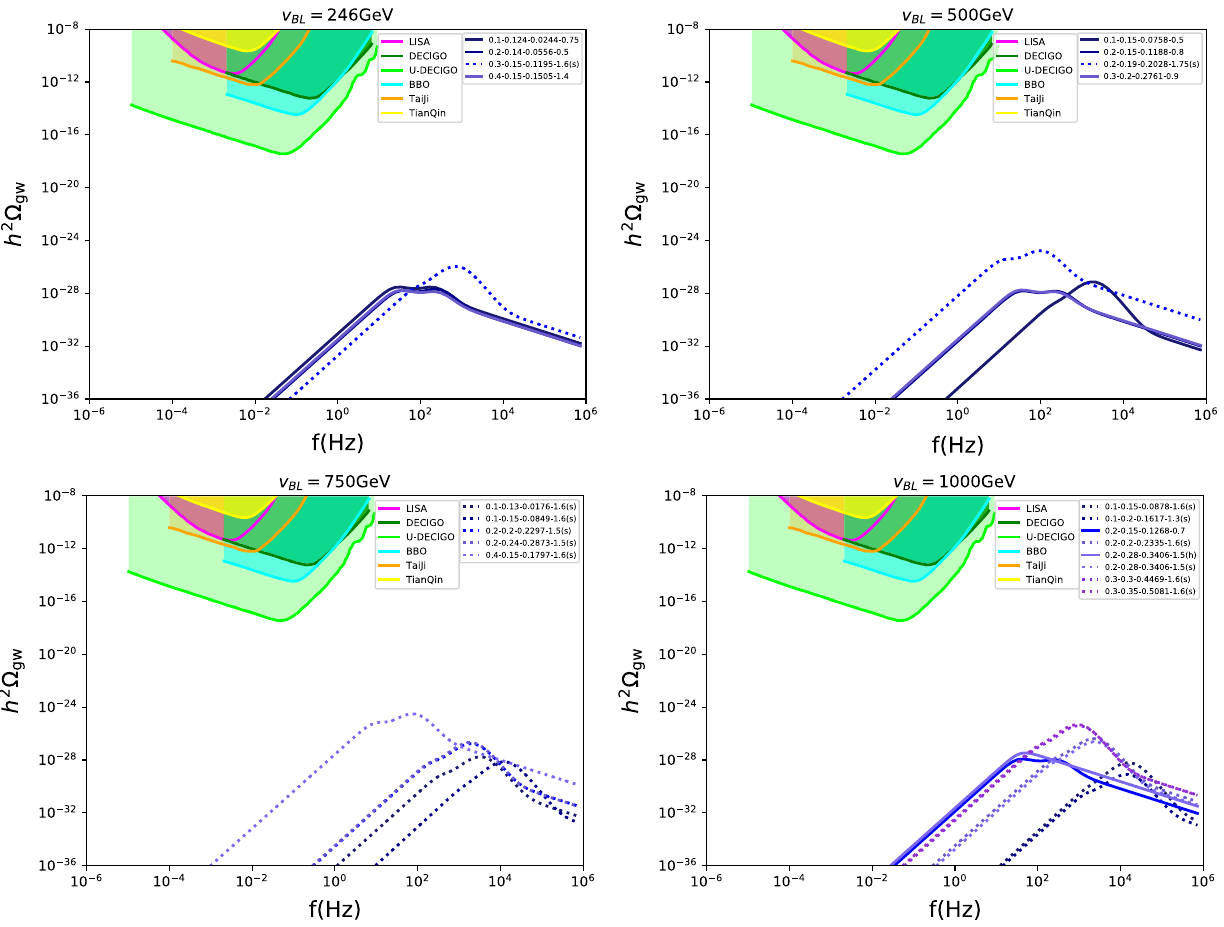
‘ λ s − λ h − λ sh − g ’. The solid lines refer to GWs from hybrid PTs, the dotted lines refer to s -direction PTs. For parameters which lead to twice first-order PTs, we have used suffixes ( h ) or ( s ) to make it clearer /( 2 × v 2 ) , and λ = 0. LM: low mass region; IM: intermediate mass region; sh e w H , SM